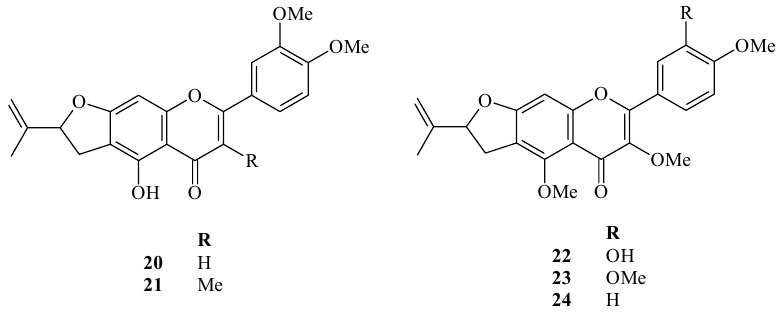
Fig. 6 – Structures of the Monoisoprenylated flavonols isolated from V. graminifolia .